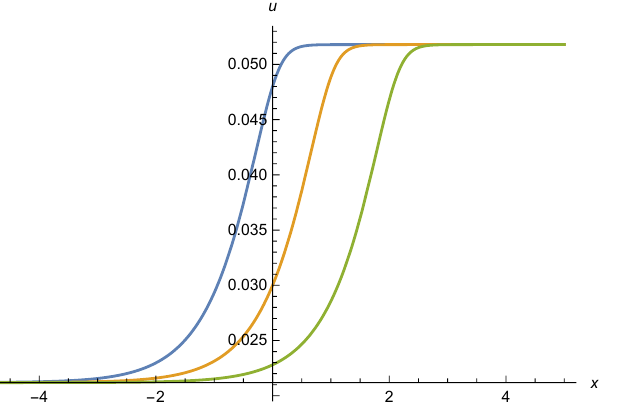
Figure 2. Scaling potential u as a function of x = ln ( ˜ ρ ) . The three curves correspond to different initial conditions, which may be specified by u ( x = 0 ) . The parameters are N = 12 and w = 0.06.